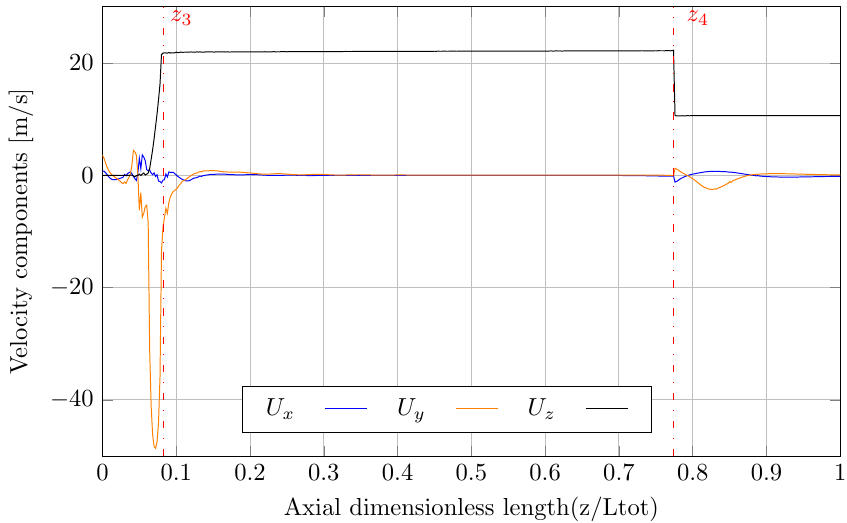
Figure 12. Velocity components averaged over section z (constant), plotted against z / L tot [ d = 0.77 mm, L = 32.2 mm, D = 3.6 mm, p 2 = 90 kPa].